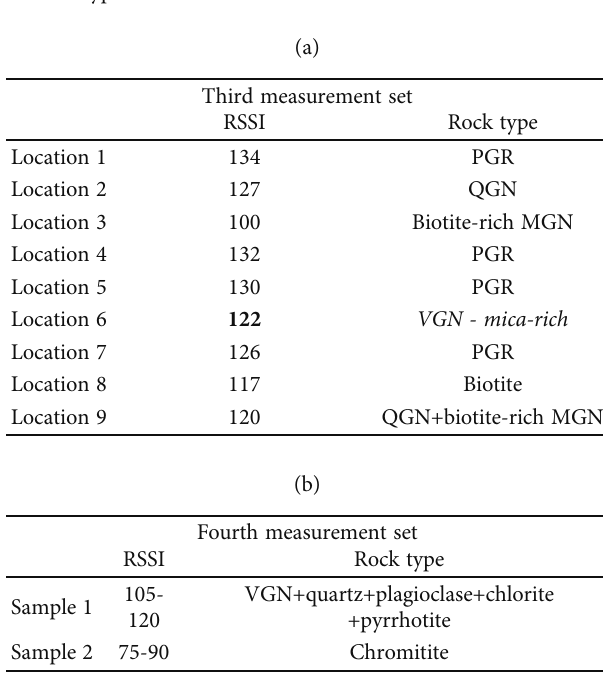
Figure 9: Measured RSSI and susceptibility values and their averages. Table 3: The third measurement set and the fourth measurement Table 4: RSSI value changes by rock set rock types and RSSI value.